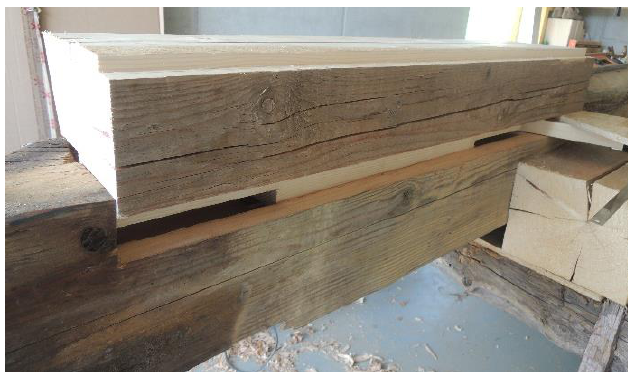
Figure 29. Formation of the insert and the gradual fitting.